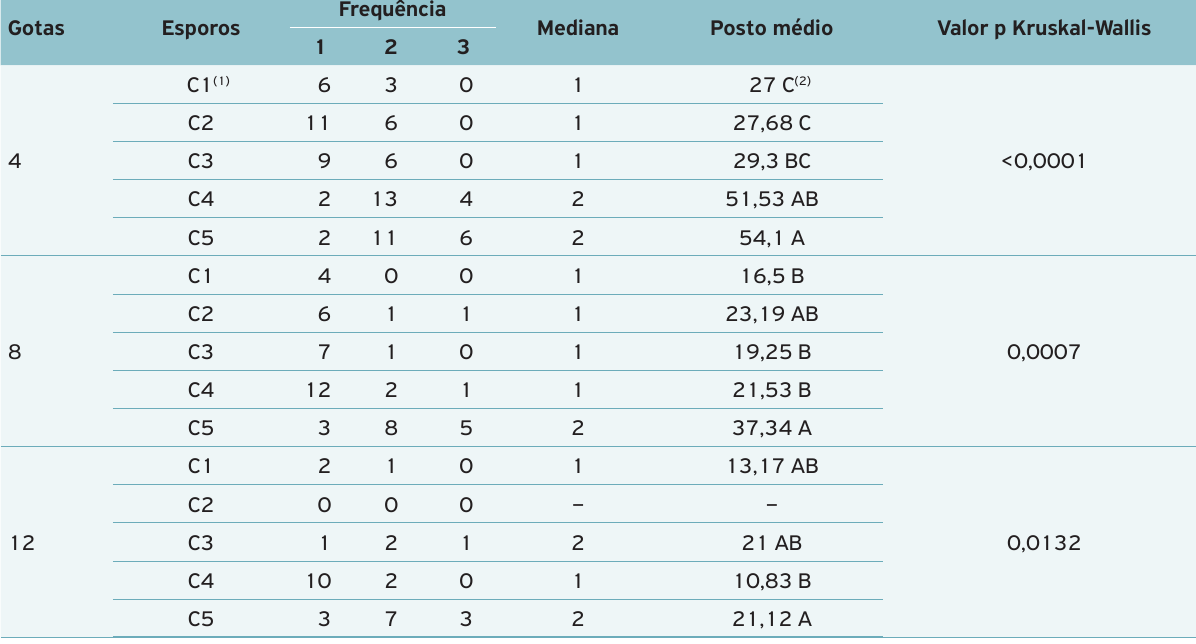
Tabela 6. Comparação dos postos médios das intensidades de linha de teste dos resultados positivos, para as classes de número de esporos dentro de cada quantidade de gotas da solução extratora utilizada.